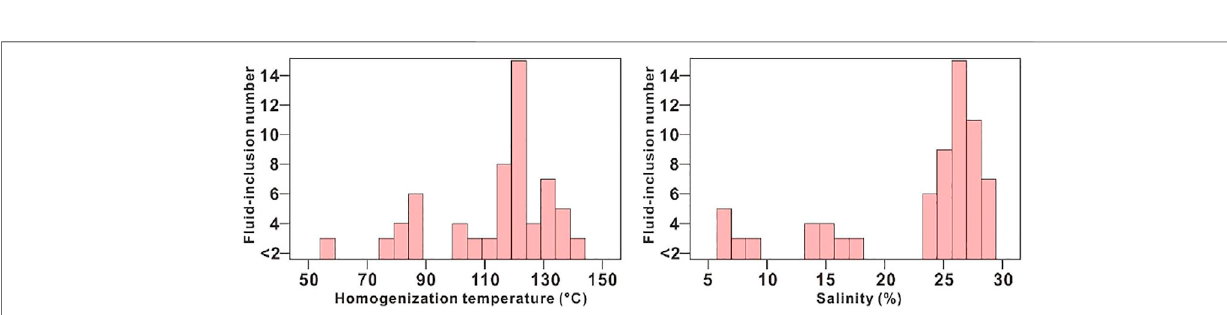
Frontiers in Earth Science |